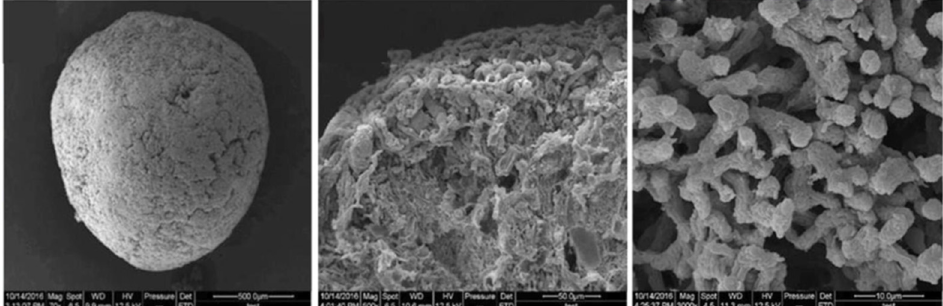
Figure 1. SEM images of the outer surface and interior of zoogloea type AGS. Adapted from refer- ence [21] (copyright reserved Elsevier, 2018).